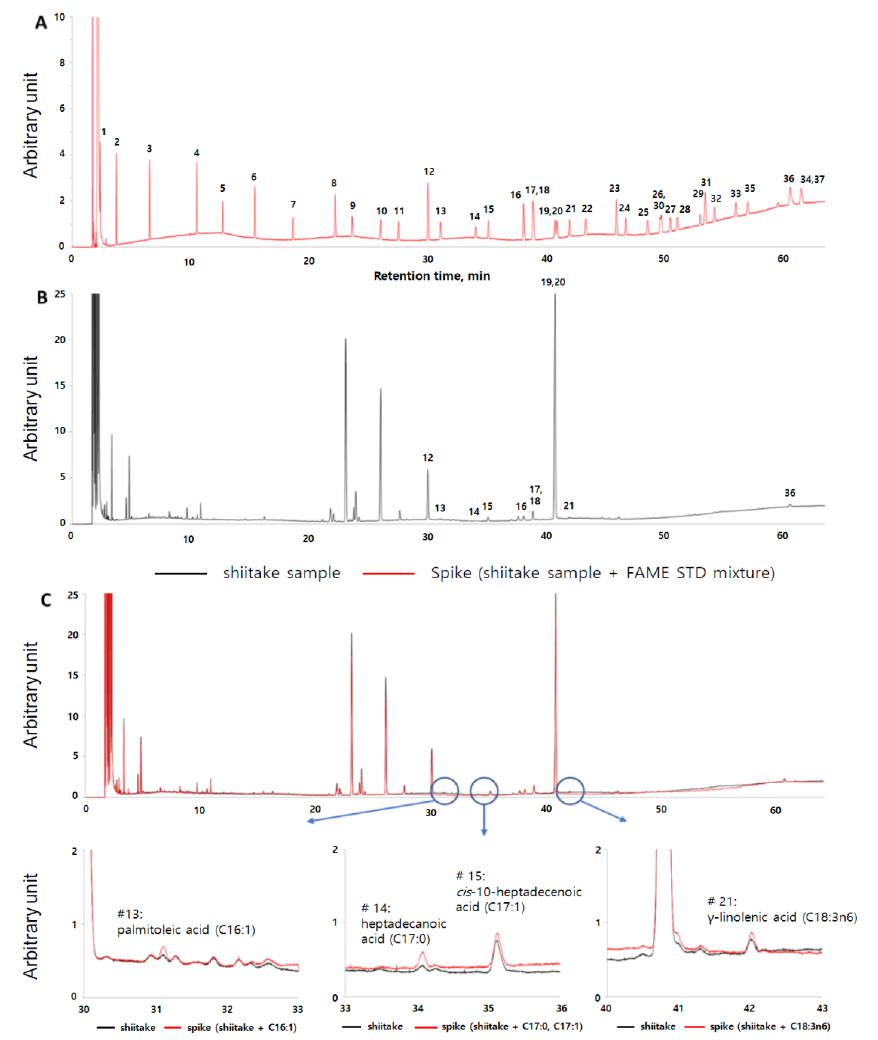
Figure 1. Gas chromatography coupled with a flame ionization detector (GC-FID) chromatograms of fatty acids (FAs) in shiitake mushrooms. ( A ) Chromatograms of the 37-FAME standards. ( B ) First